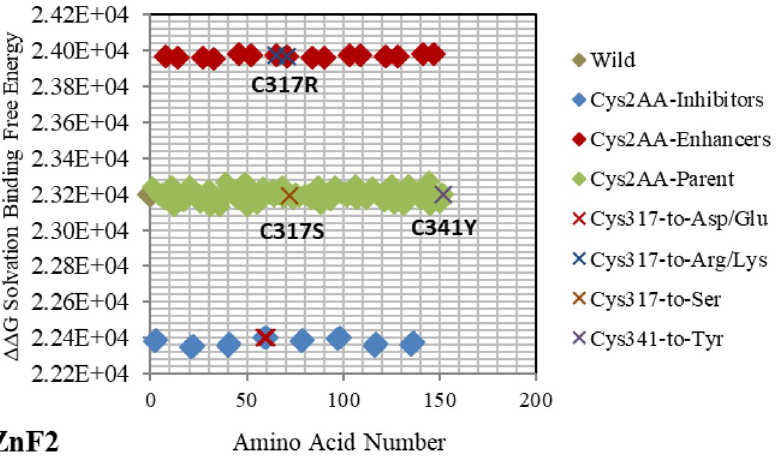
Figure 5. Electrostatic free energy differences of Cysteine (Cys/C) within GATA3:DNA complex. Plot presents the solvated binding free energy calculations (in KJ/mol) GATA3 Cys amino acid mutants in both of Chain-D and Chain-C.